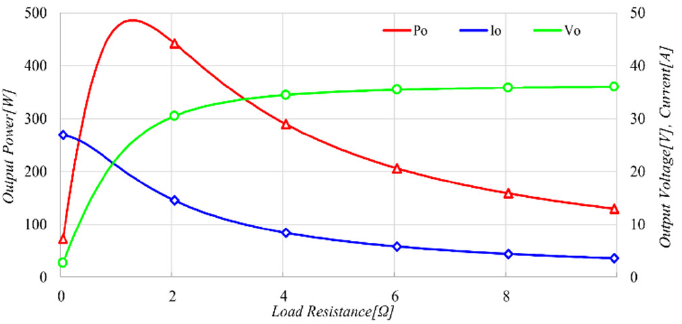
Figure 6. Output characteristics of the proposed topology under different loads.